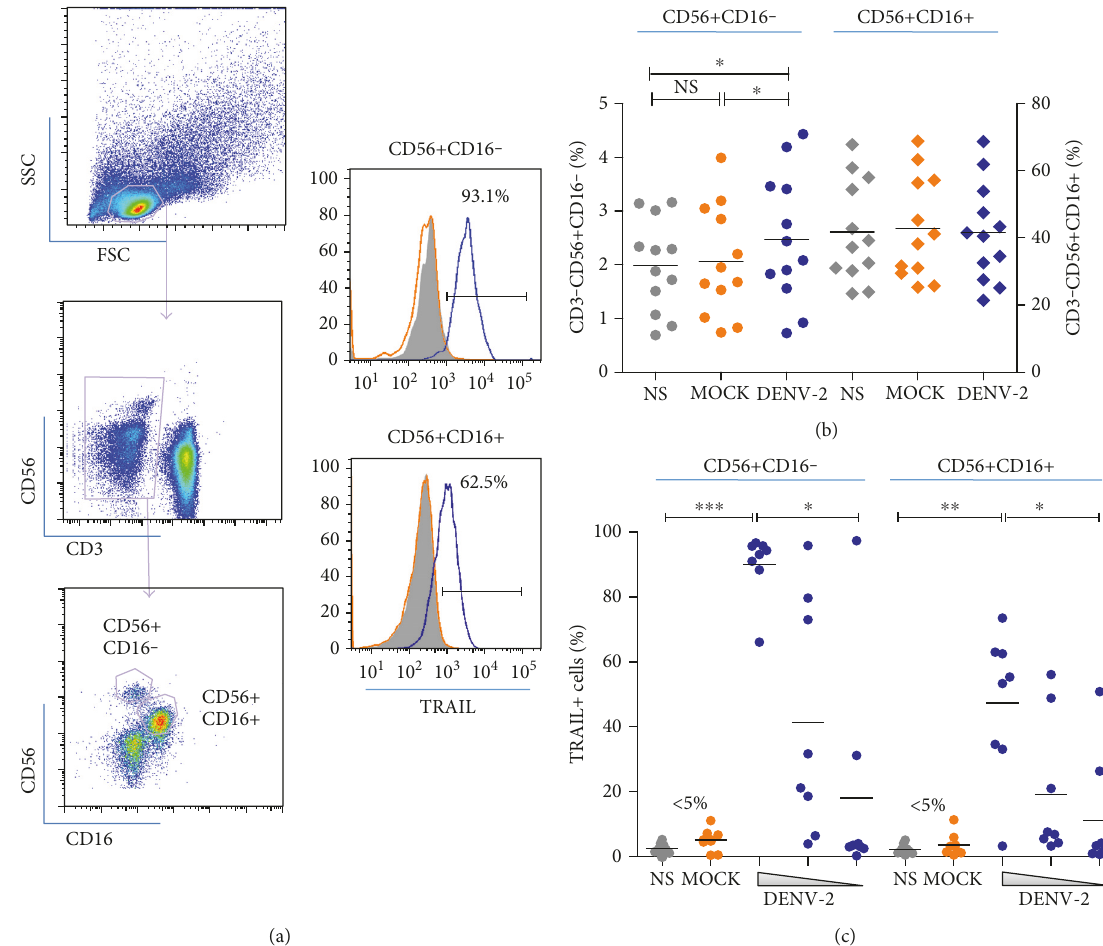
Figure 3: DENV-2-stimulated NK cells: subpopulation frequencies and TRAIL expression analysis. Healthy donors ’ PBMCs were freshly obtained and subsequently stimulated with DENV-2 at several multiplicities of infection (10, 1, and 0.1) or negative controls as MOCK (uninfected C636 cell culture supernatant) or not stimulated (NS) for 18 hours. (a) NK cells were gated as CD3 − CD56+CD16+ or CD3 − CD56+CD16 − and TRAIL-positive cells were detected for each subpopulation. (b) CD3 − CD56+CD16 − (left) or CD3 − CD56+CD16+ (right) frequencies among PBMCs stimulated with MOCK (orange), DENV-2 (blue) or not stimulated (gray) are shown. (c) TRAIL- positive cells among CD3 − CD56+CD16+ or CD3 − CD56+CD16 − after stimulation with DENV-2, MOCK, or not stimulated. Values were submitted to Friedman ’ s test with Dunn ’ s multiple comparison test in which di ff erences with p < 0 05 ( ∗ ), p < 0 005 ( ∗∗ ) or p < 0 0005 ( ∗∗∗ ) were considered statistically signi fi